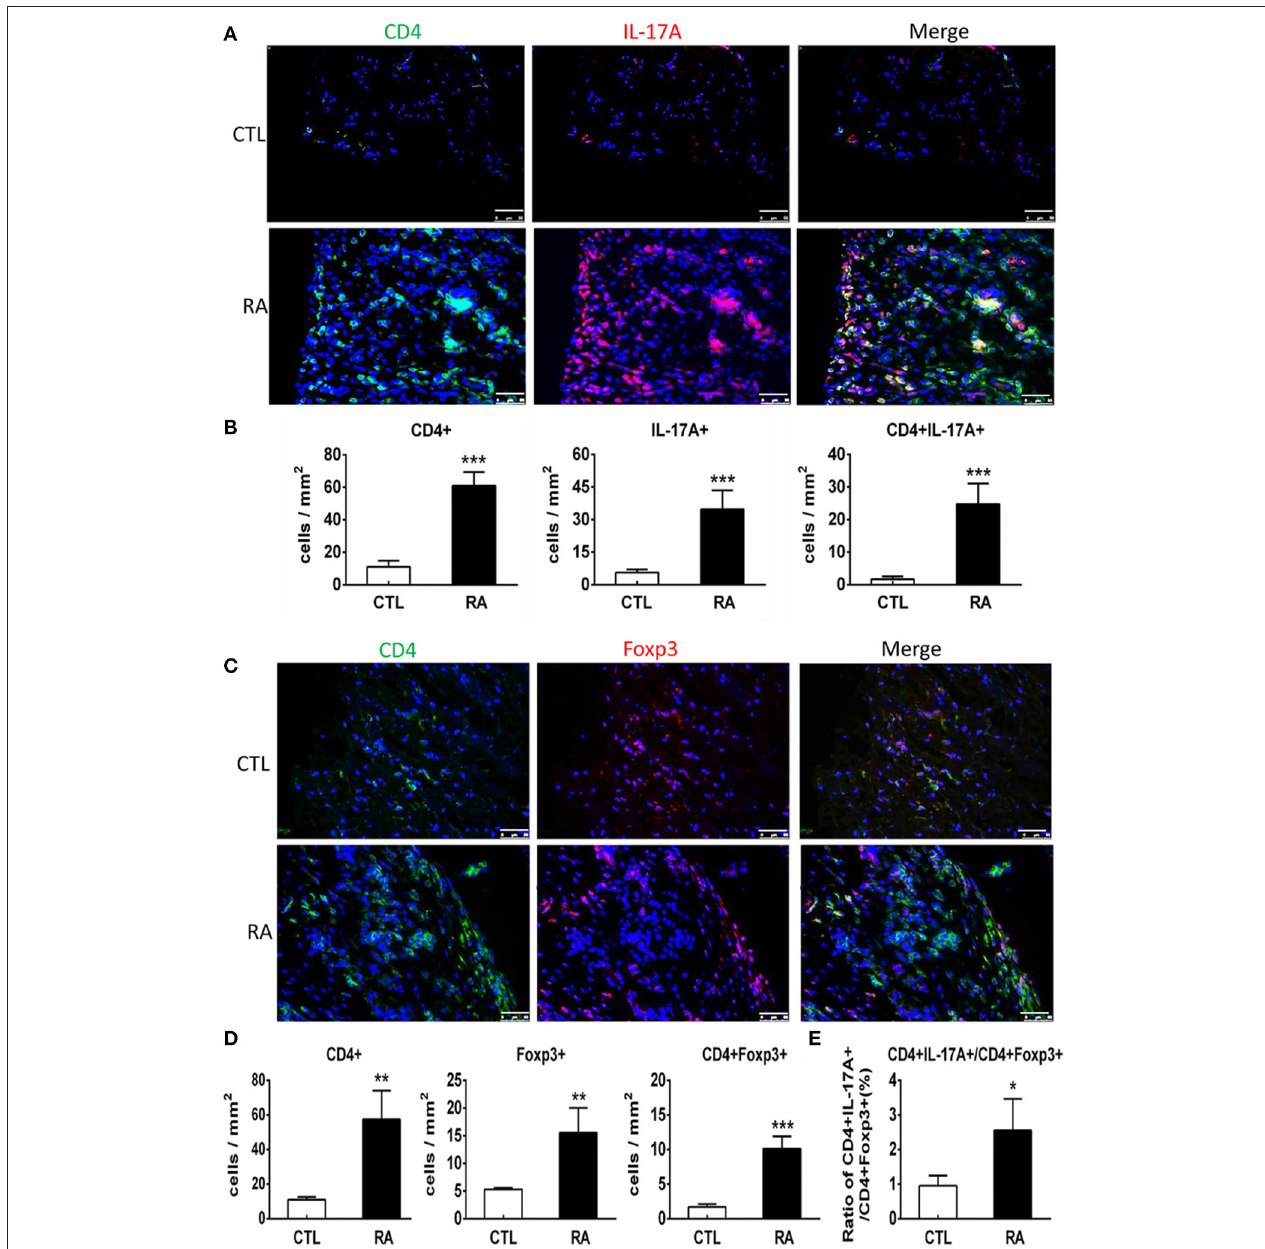
FIGURE 2 | Two-color immunofluorescence detects Th17 and Treg responses in the synovial tissues of RA patients. (A) Expression of CD4 + IL-17A + cells. (B) Quantitative analysis of CD4 + , IL-17A + , and CD4 + IL-17A + cells. (C) Expression of CD4 + Foxp3 + cells . (D) Quantitative analysis of CD4 + , Foxp3 + , and CD4 + Foxp3 + cells. (E ) Ratio of Th17/Treg cells. Note that there is a 2.7-fold increase in the number of CD4 + IL-17A + cells compared to CD4 + Foxp3 + cells in patients with RA. Data represent mean ± S.E. for 14 RA patients. * p < 0.05, ** p < 0.01, *** p < 0.001 compared to normal controls. Scale bar, 50 µ m.